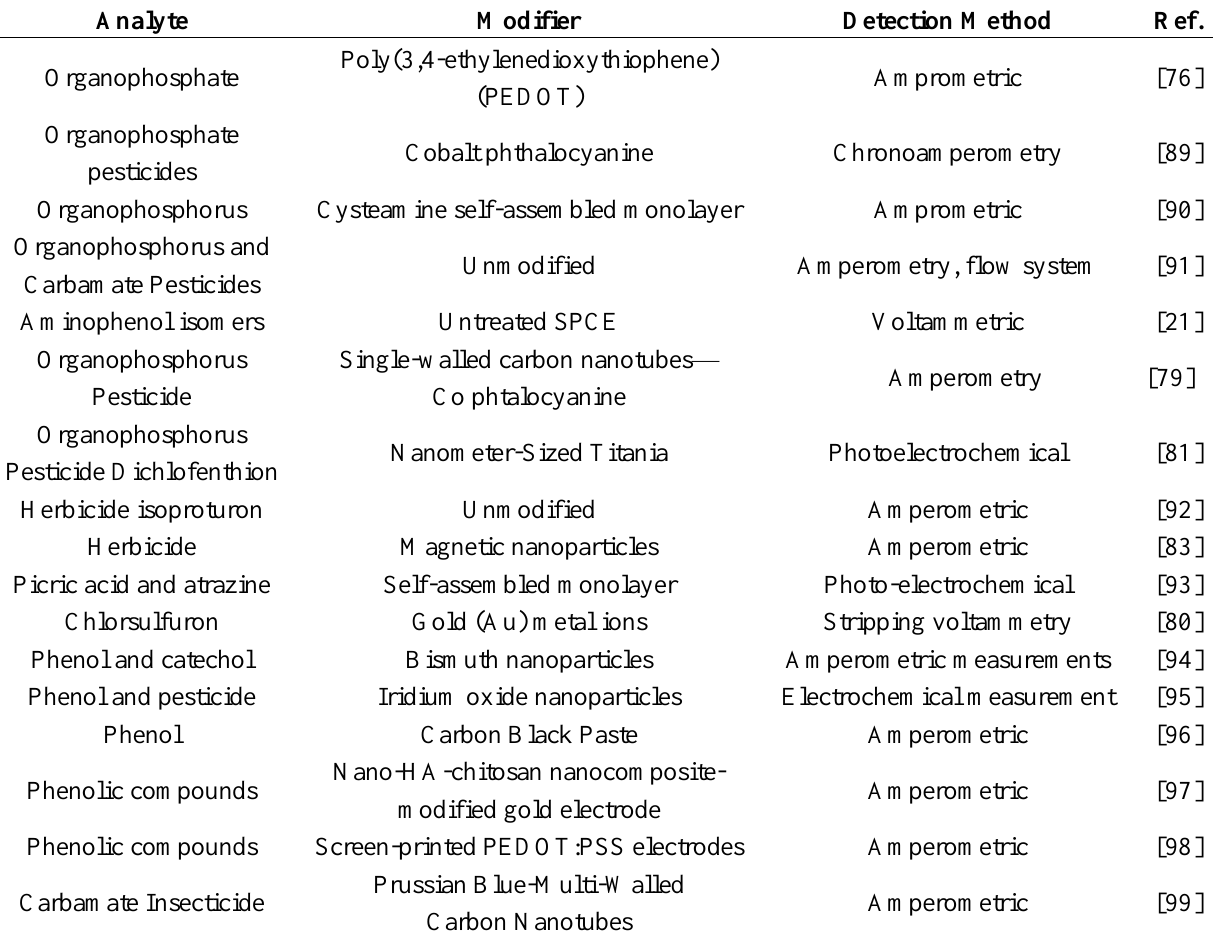
Table 2. Examples of the some of the recently developed screen printed sensors for organic compounds detection in environmental